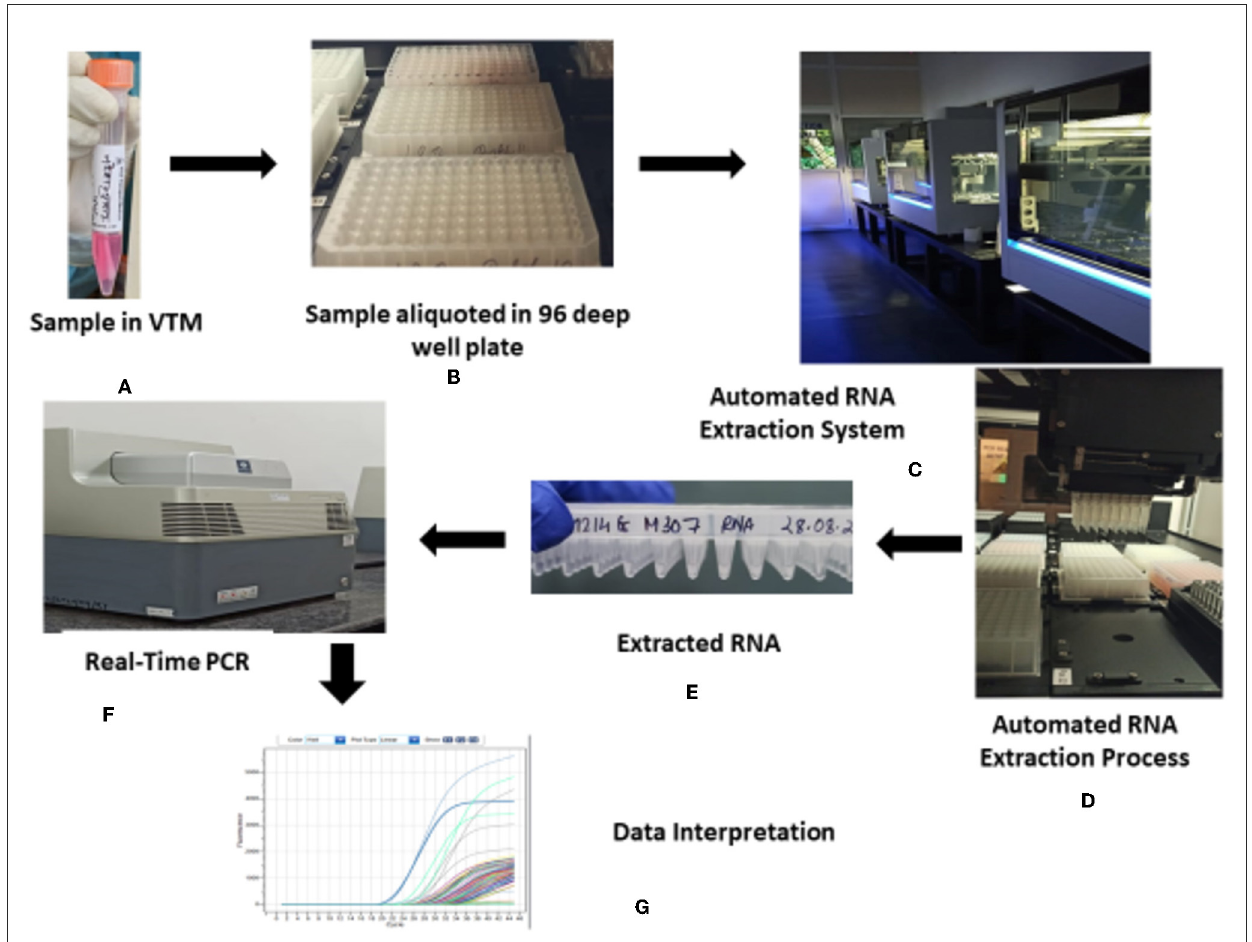
FIGURE4 Overview of the HTL, NICPR COVID-19 testing consortium. (A) Sample in VTM. (B) Sample aliquoted in 96 deep well plate. (C) Automated RNA extraction system. (D) Automated RNA extraction process. (E) Extracted RNA. (F) Real-time PCR. (G) Data